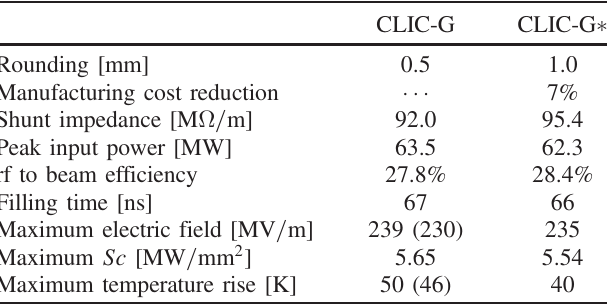
TABLE I. Structure parameters of CLIC-G (cid:2) design. The parameters of CLIC-G inside the braces are given in [2], outside are recalculated in latest HFSS version.